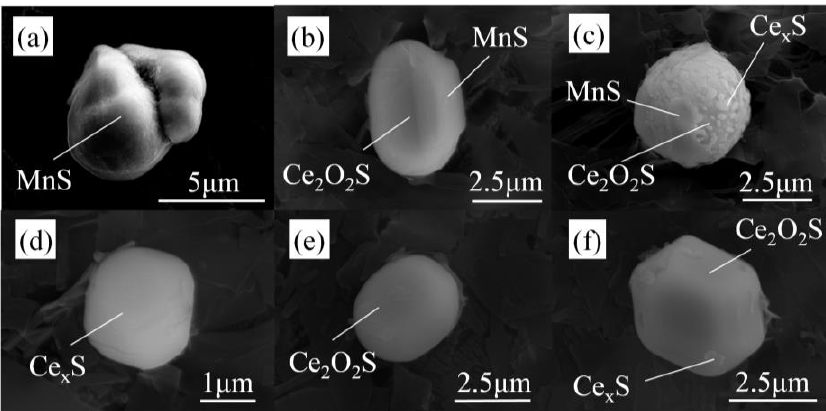
Figure 6. Three-dimensional morphology of typical inclusions in steel samples: ( a ) 0 ppm, ( b ) 52 ppm, ( c , d ) 139 ppm, 171 ppm, 256 ppm, ( e , f ) 340 ppm.